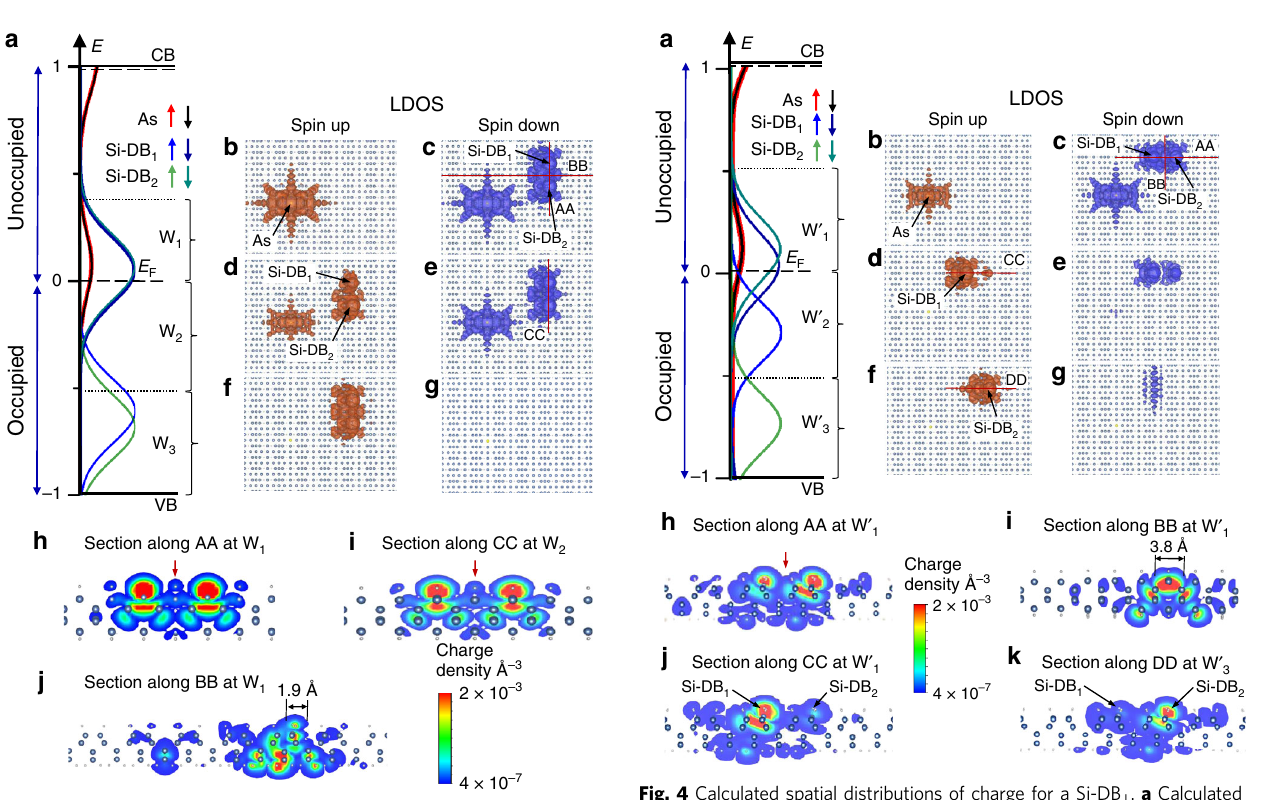
mainly localized on the left side of the Si-DB ⊥ (Si-DB 1 in Fig. 4d) and the other spin-up LDOS part on the right side of the Si-DB ⊥ at W ′ 3 (Si-DB 2 in Fig. 4f). The sectional drawings of the LDOS crossing the Si-DB ⊥ along the CC and DD sections at W ′ 2 and W ′ 3 con fi rm this effect and reveal tilted LDOS intensities at each Si-DBs of the line (Fig. 4j, k) that extend to the neighbor Si-DBs. This is showing a clear signature of the Si-DB hybridization through the silicon subsurface.